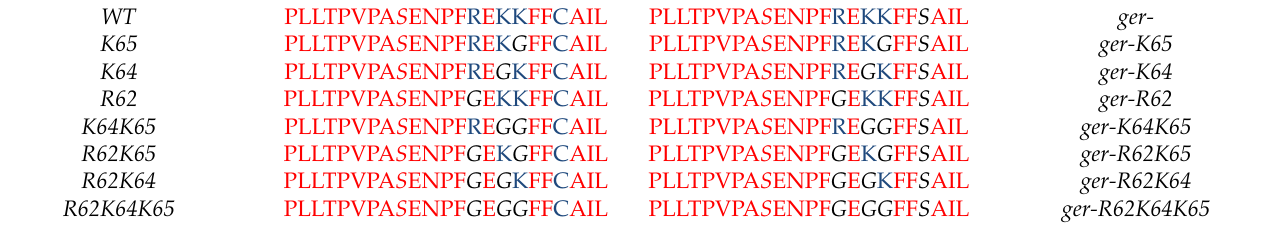
Table 4. Site-directed mutagenesis of G γ 2